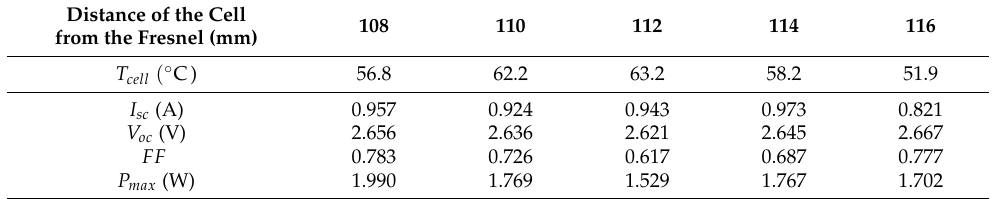
Table 3. The output performance and temperature of the cell at different positions of the optical